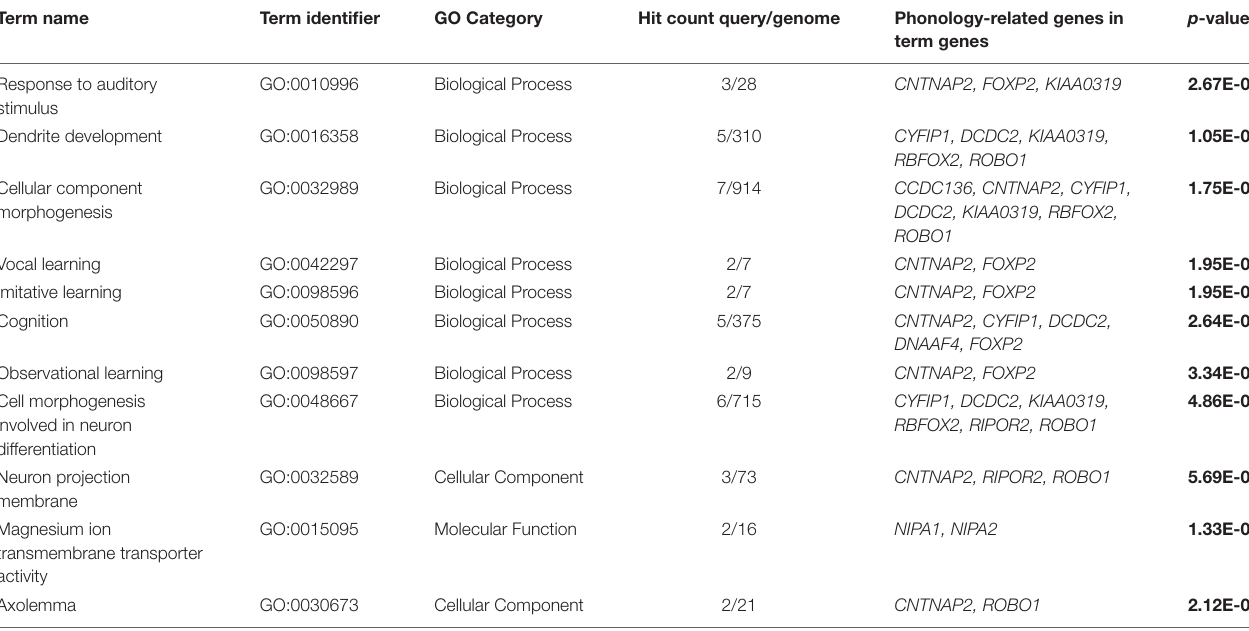
TABLE 1 | Results of the functional enrichment analysis of phonology-related